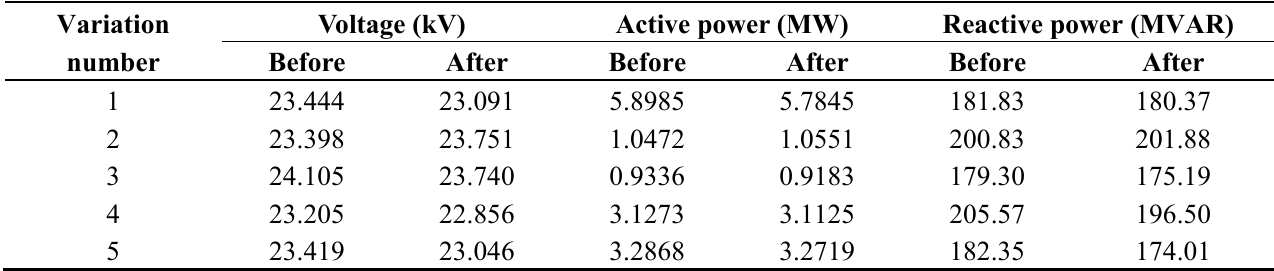
Table 6. Korean EMS data for the 673th transformer bank on winter evenings